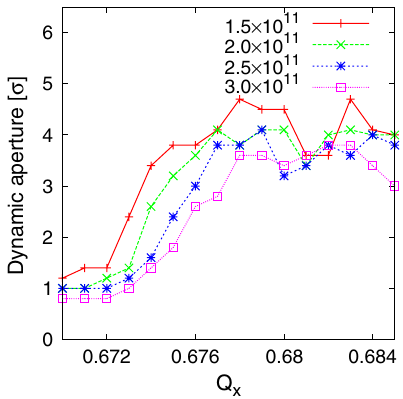
FIG. 13. Dynamic aperture of half head-on beam-beam com- pensation with a mismatched electron beam size. The electron bunch intensity is keep constant here. Four proton bunch in- tensities are